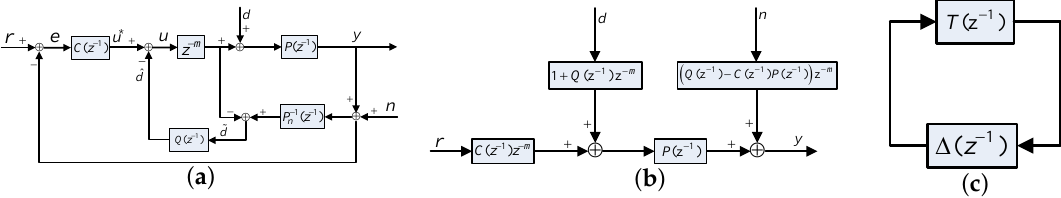
Figure 4. Control block diagram with general DOB: ( a ) block diagram of general DOB; ( b ) equivalent block diagram of DOB when ∆ ( z − 1 ) = 0; ( c ) robust stability based on the small gain